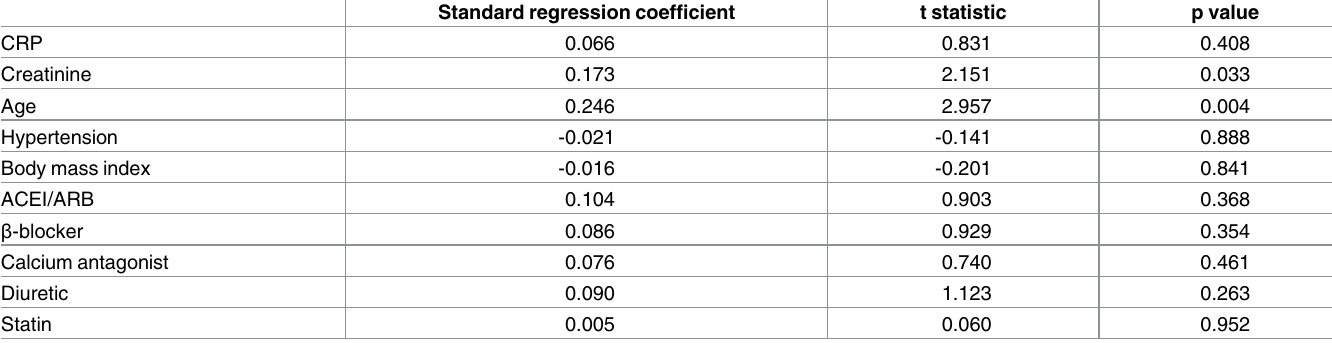
Table 3. Multiple regression analysis of the BNP levels and potential associated factors in patients without cancer.